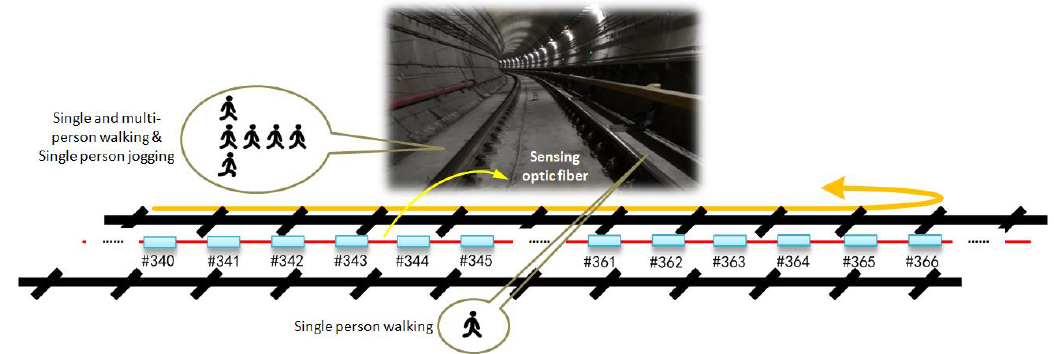
Figure 5. Simulated human intrusion scenarios along the rail track in the selected tunnel area.